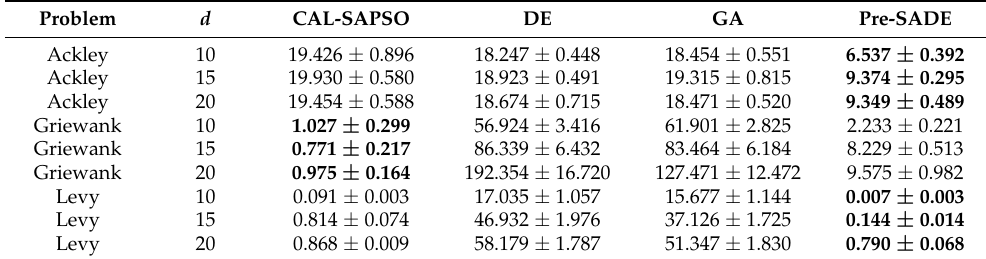
Table 2. The optimization results of the optimized value of CAL-SAPSO, DE, GA, and pre-SADE. Problem